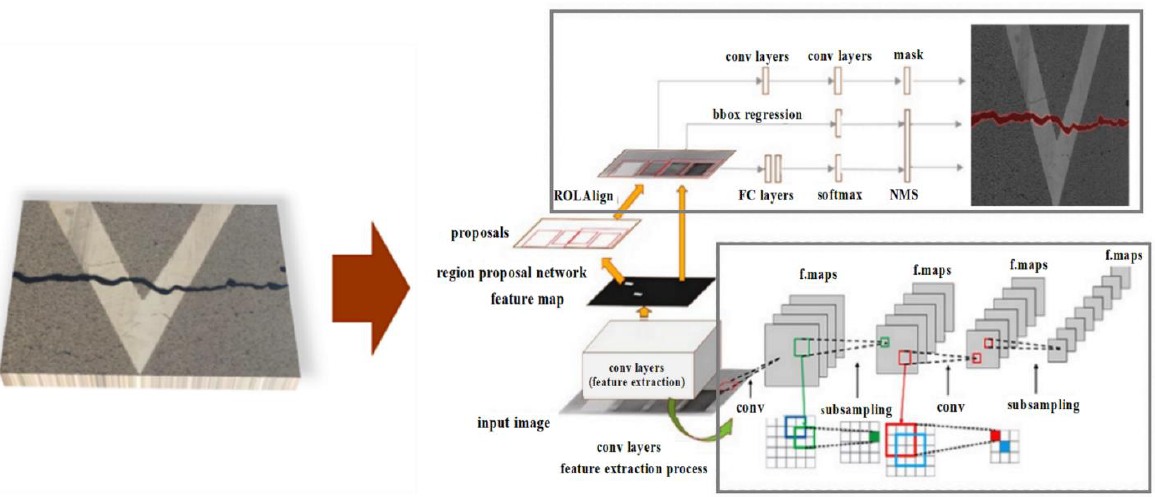
Figure 4. Schematic diagram of the model building process.